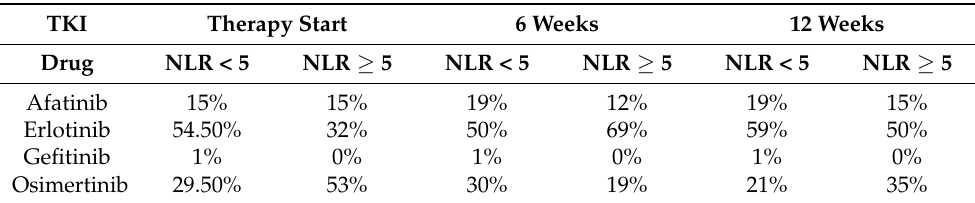
Table 2. Distribution of TKI use at time of therapy start, 6 weeks and 12 weeks for patients with NLR < 5 and NLR ≥ 5. TKI